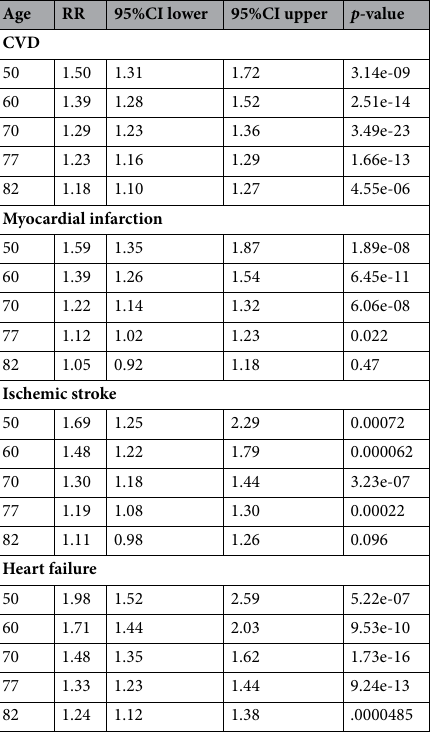
Table 3. Risk ratio (RR), 95%CI and p-value for the risk of incident cardiovascular disease (CVD, combined end-point), myocardial infarction, ischemic stroke and heart failure for the number of metabolic syndrome (MetS) components at different ages. RR is given for a one risk factor increase. The RRs were adjusted for LDL cholesterol, education level (years in school), leisure time exercise habits, smoking and use of medication against